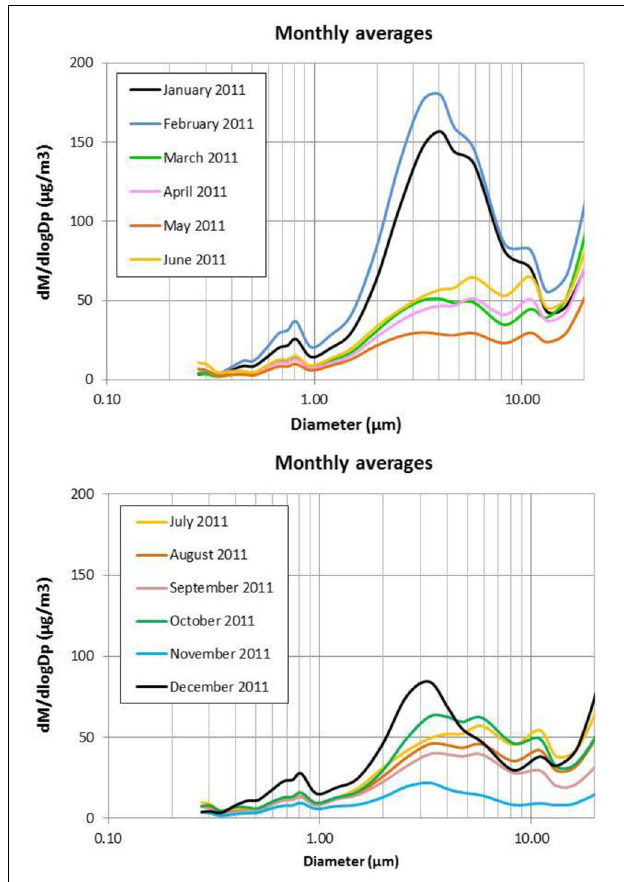
FIGURE 11 | Monthly averaged mass concentration size distributions of the Praia atmospheric aerosol, for every 2011 month.